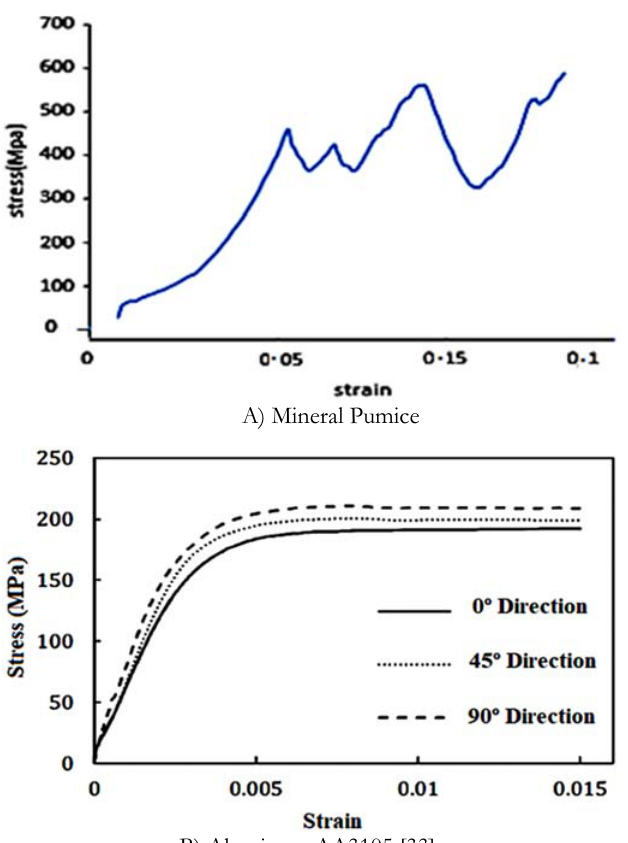
Figure 22: Stress-strain